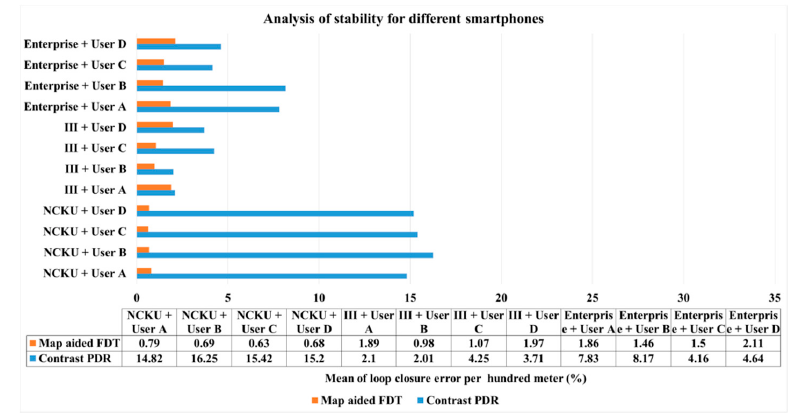
Figure 17. Analysis of stability for different smartphones.